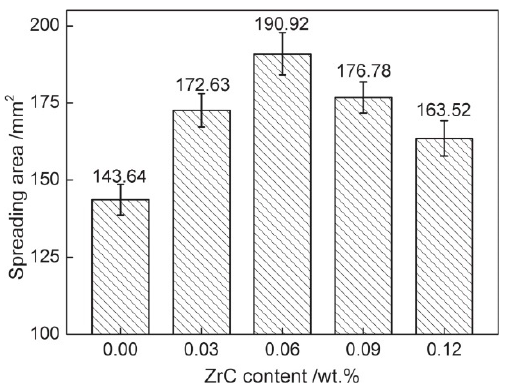
Figure 14. Spreading area of SnZn–xZrC (x = 0, 0.03, 0.06, 0.09, 0.12) composite solders [89].